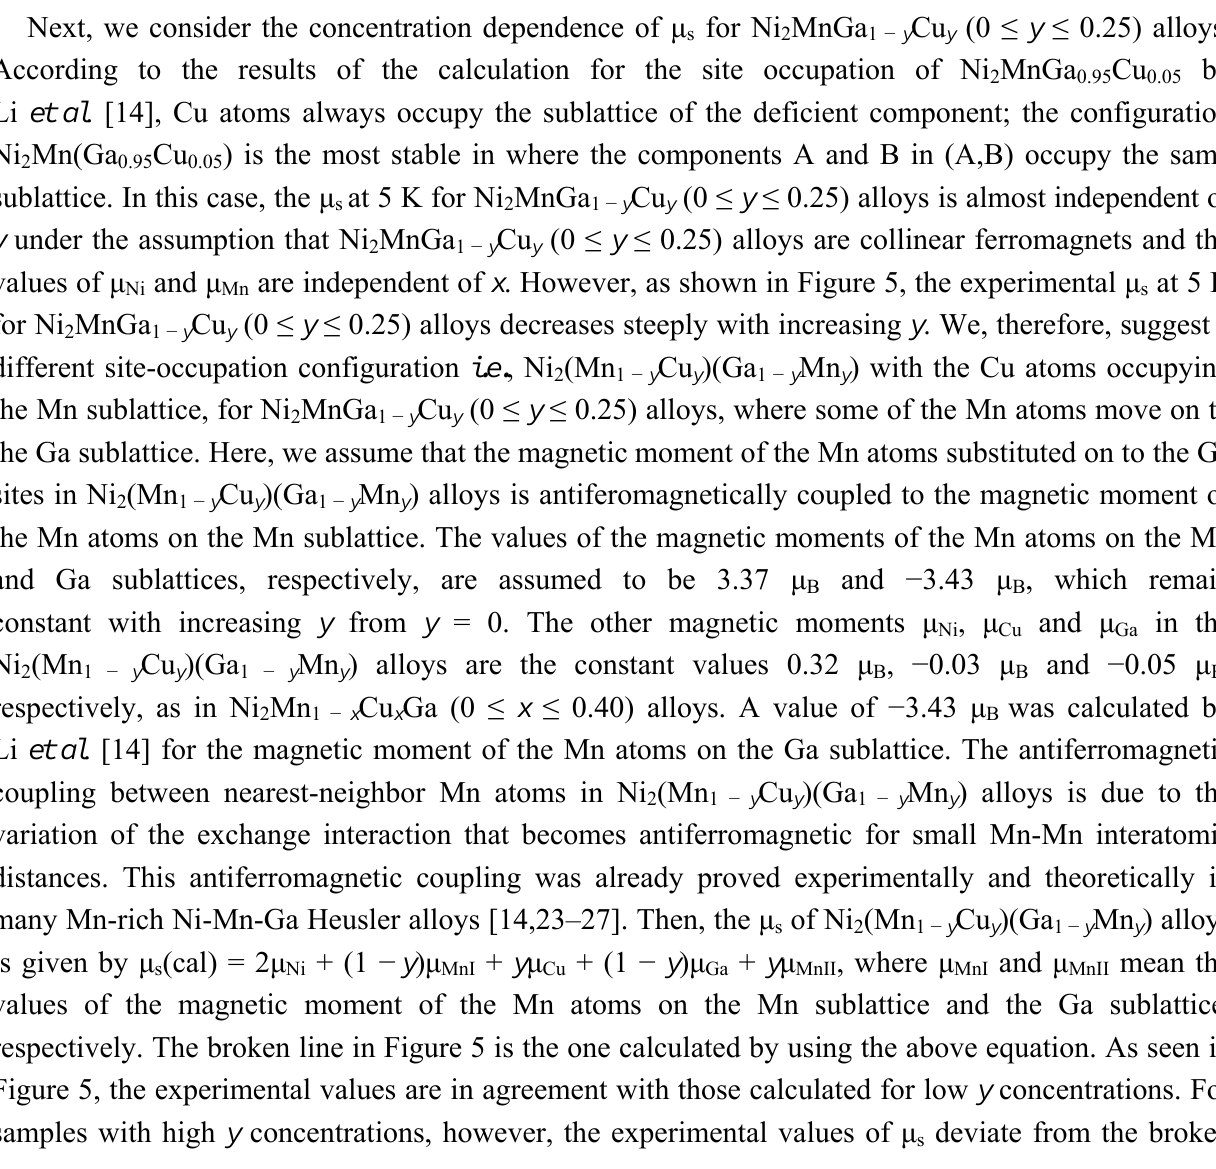
, for s Cu MnGa 2 − z z of s